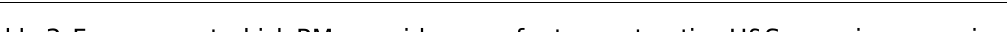
Table 3: Frequency at which PMs consider, or refer to construction H&S on various occasions Frequency